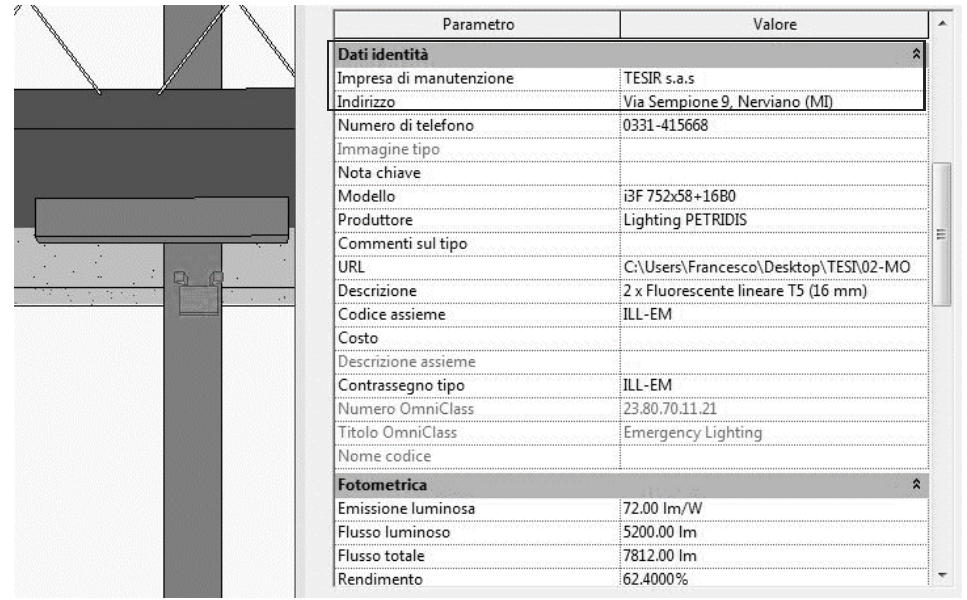
Figure 9. Building information model component database example.